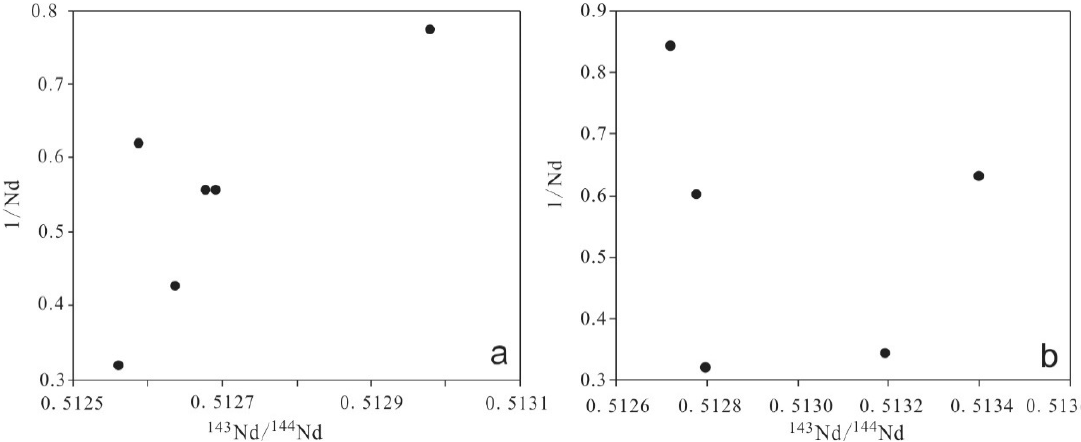
Figure 6. Diagrams of 1/Nd vs. 143 Nd/ 144 Nd of ( a ) fluorite and ( b ) calcite from the Shuiyindong deposit.